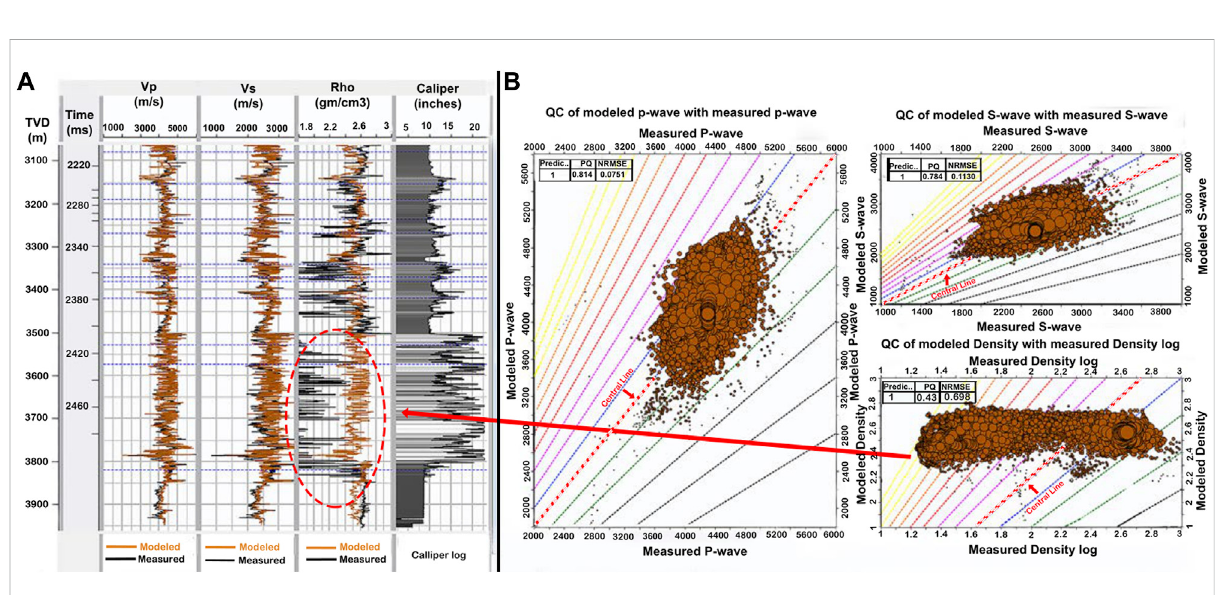
FIGURE 3 (A) Modeled Vp and Vs logs follow the measured log trend, whereas density log shows mismatch due to poor borehole condition highlighted through polygon, also illustrated by caliper log, and (B) QC cross plot displaying log points aligned at the central line for Vp and Vs; however, RHOB shows deviation due to error in wellbore